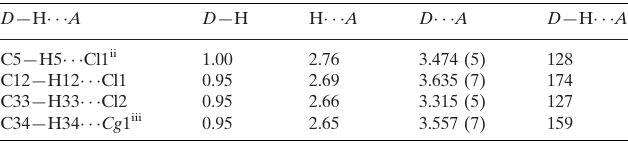
Hydrogen-bond geometry (A˚ , (cid:2)